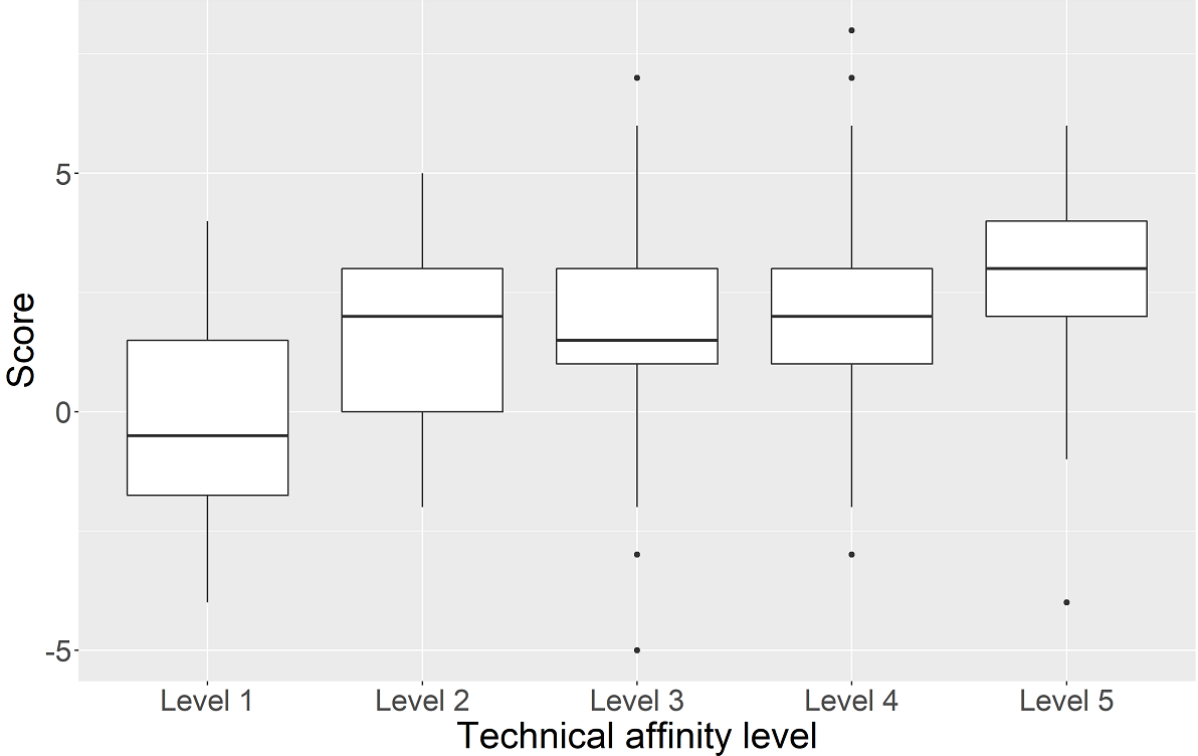
Figure 5. Attitude toward mobile devices stratified by (self-reported) technical affinity